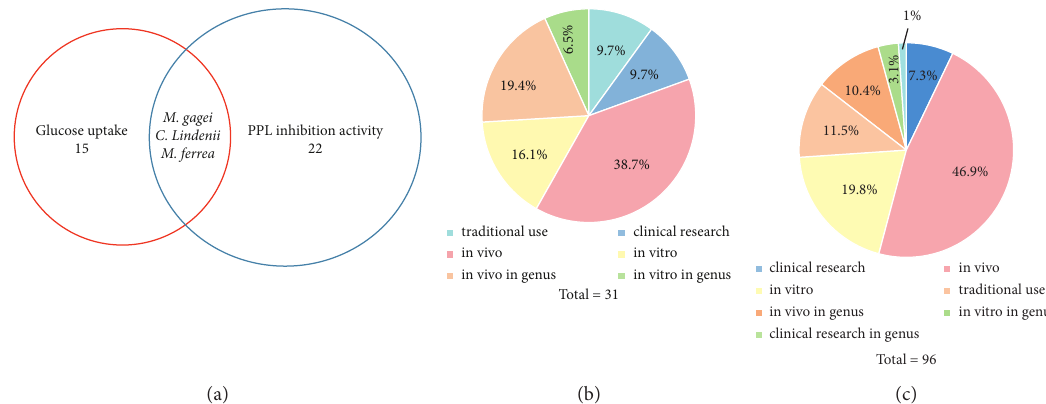
Figure 2: (a) The species possessed the PPL inhibition activity and stimulated glucose uptake in 3T3-L1 adipocytes. (b) Research status of traditional plants showing antidiabetic activities in our study. (c) Research status of extracted antidiabetic plants.